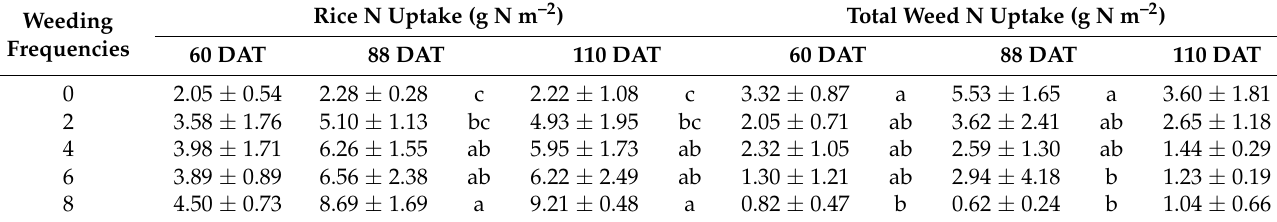
Table 2. Effect of weeding frequencies on nitrogen uptake of rice and total weeds at 60, 88, and 110 DAT (days after transplantation). Values are given as mean ± standard deviation. Values followed by different letters in each column are statistically different at p < 0.05 based on Tukey’s HSD test. 0, 2, 4, 6, and 8 was the frequency of mechanical weeding until 49